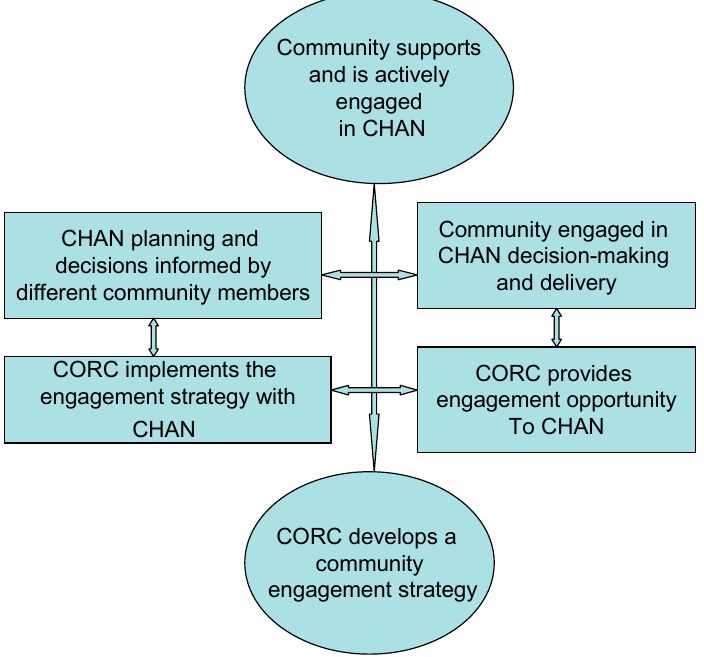
Figure 1. Model to initiate community engagement.